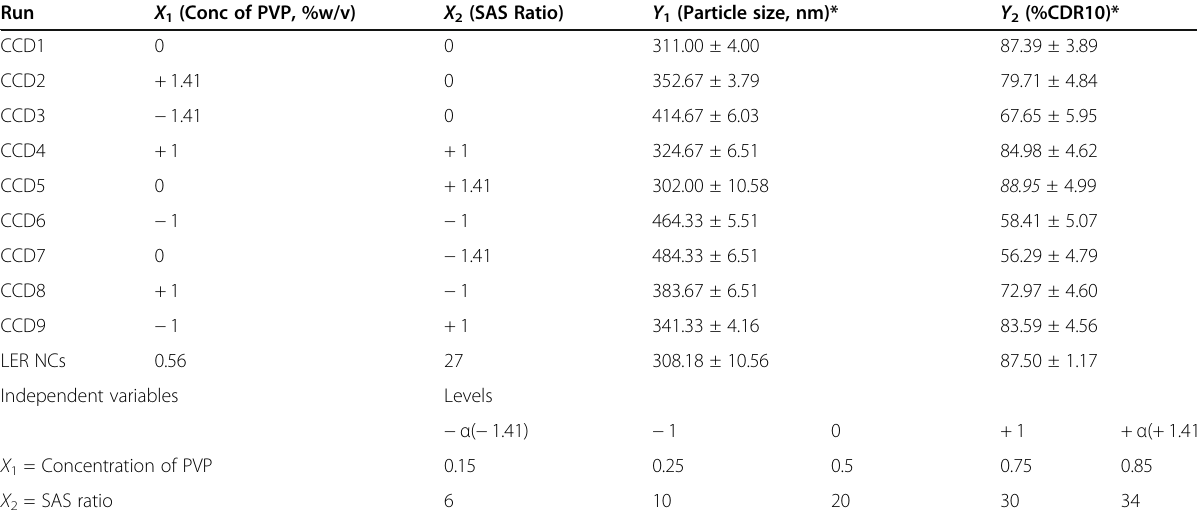
Table 1 Layout of central composite design batches (*average ± SD, n = 3)